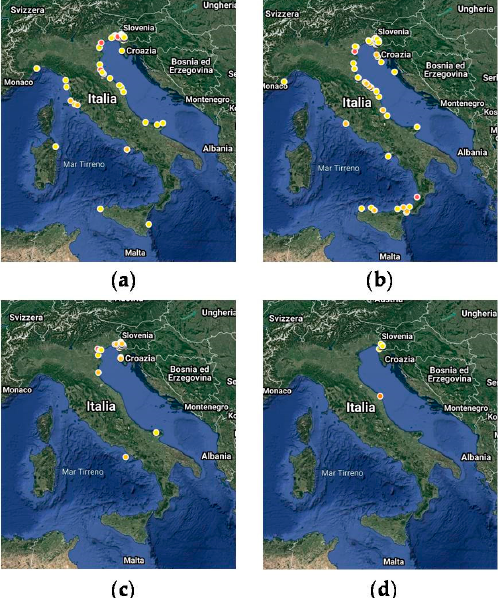
Figure 10. Maps of sighting locations with reported abundance range (yellow dot: 1 ind. m − 2 ; orange dot: 1–10 ind. m − 2 ; red dot: >20 ind. m − 2 ) for: ( a ) R. pulmo ; ( b ) C. tuberculata ; ( c ) Aurelia spp.; ( d ) A. forskalea .